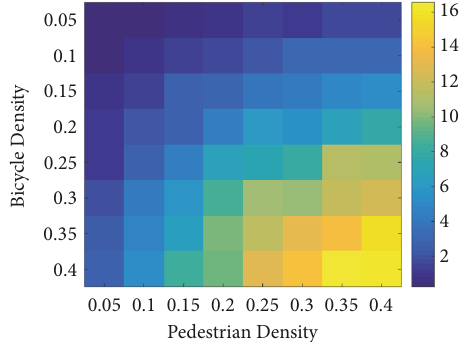
Figure 9: Average conflict numbers per second for path with con- ventional bus